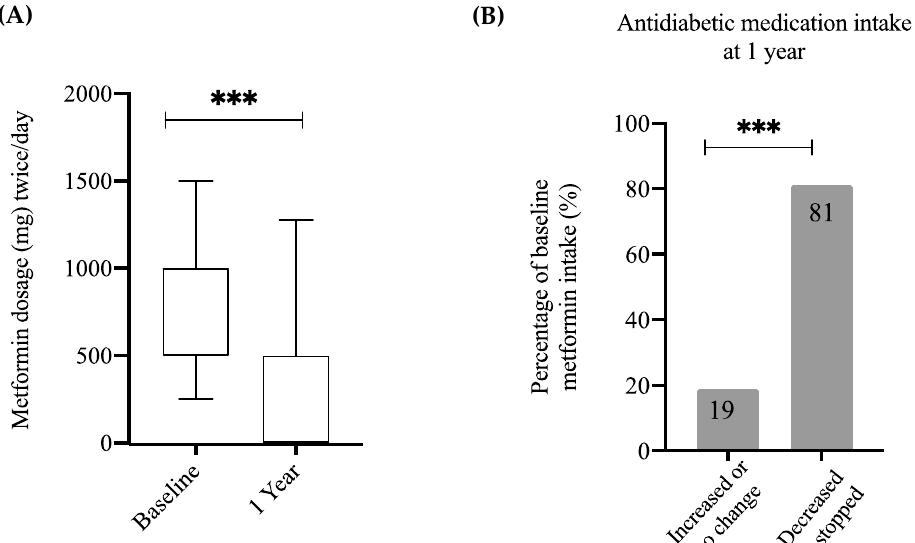
Figure 2. Changes in anti-diabetic medication intake post-surgery. ( A ) Boxplot displaying the distribution of Metformin intake at baseline and one-year post-surgery among patients with T2DM. ( B ) Percentage distribution of patients with T2DM at baseline who increased or did not change their dose of Metformin and those who stopped or reduced their dose of Metformin. Statistical differences between dose at baseline and dose at one year were obtained via 2-tailed paired t -test whereas statistical differences between subgroups of qualitative variables were obtained using chi-squared and McNemar tests: *** p < 0.001.